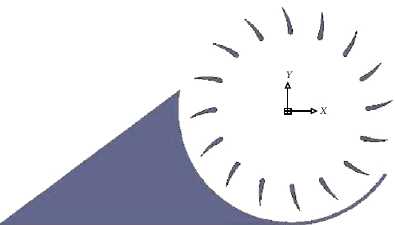
Figure 3: Fan-wing section with single leading edge